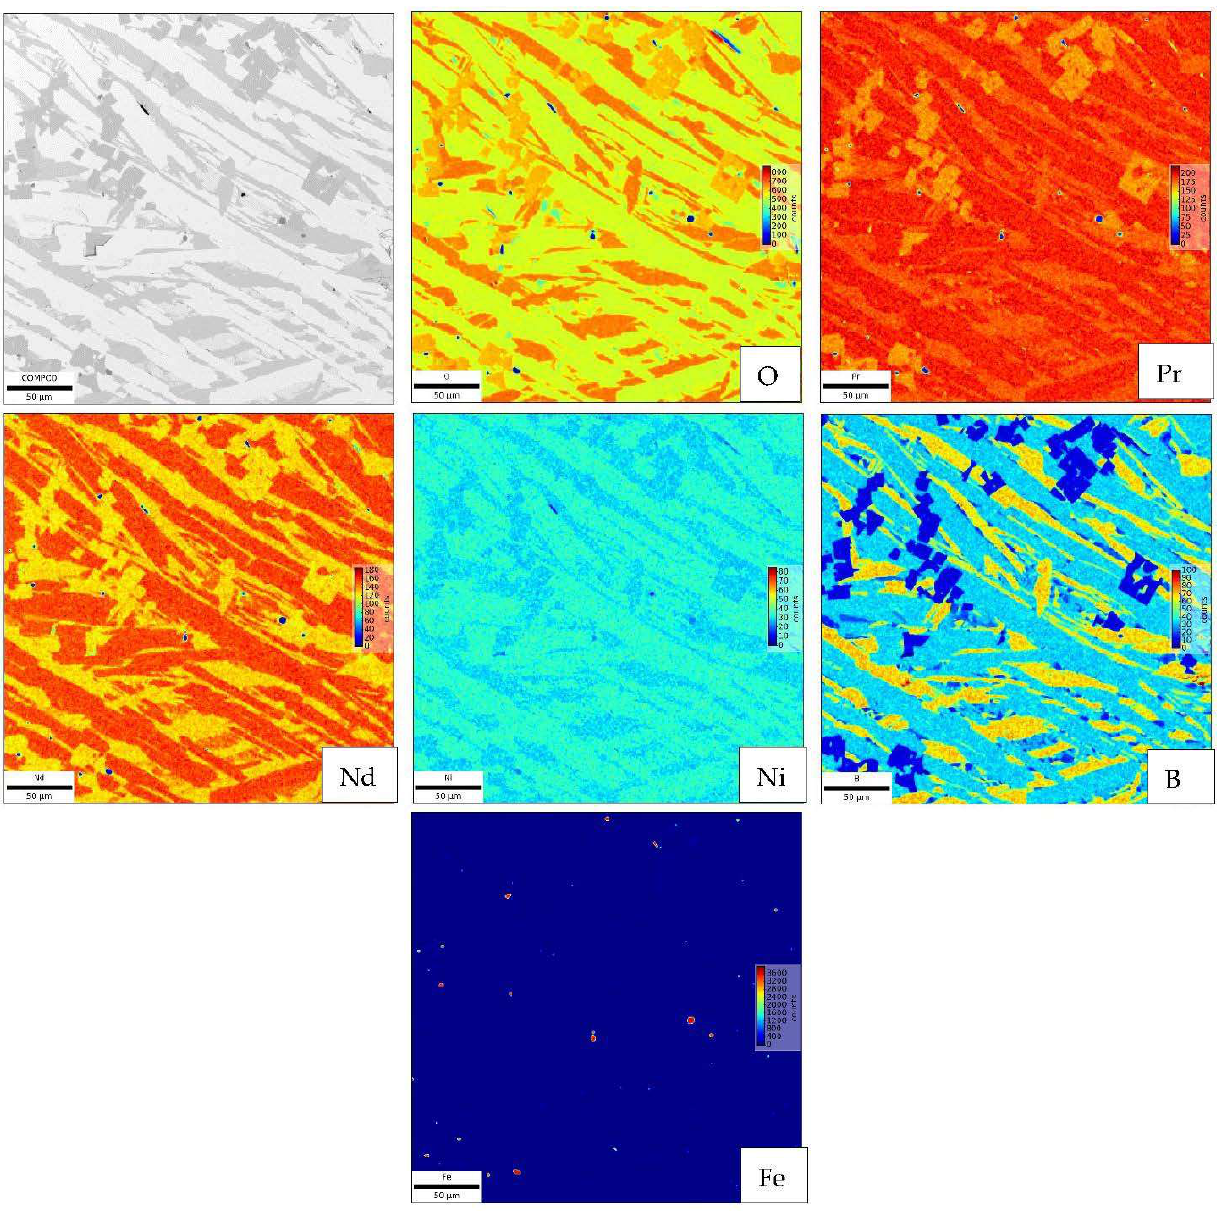
Figure 10. SEM-EDS mapping of slag phase from V3.